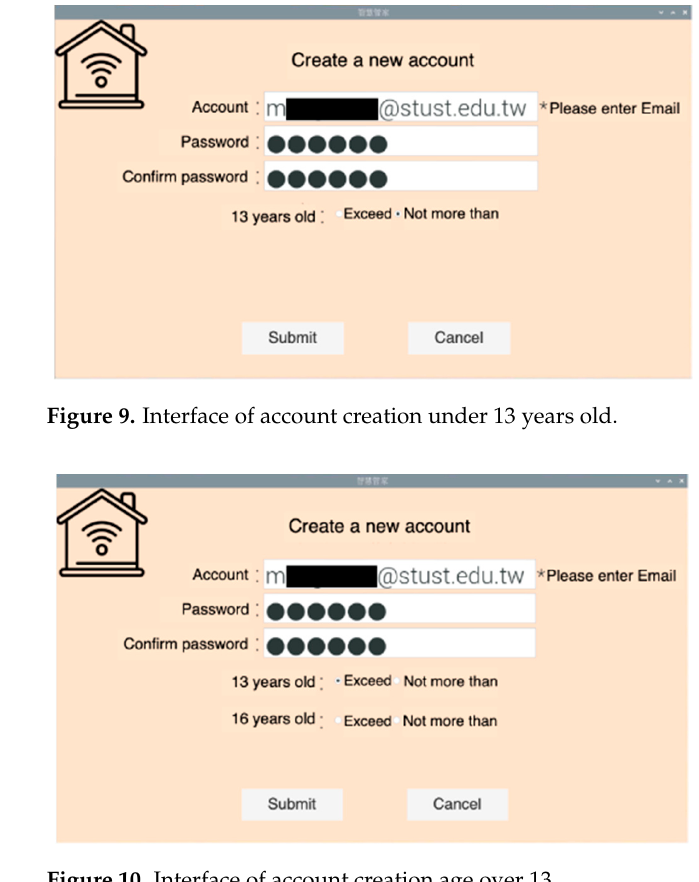
17 of 23 Figure 7. Sequence diagram of user and server operation.